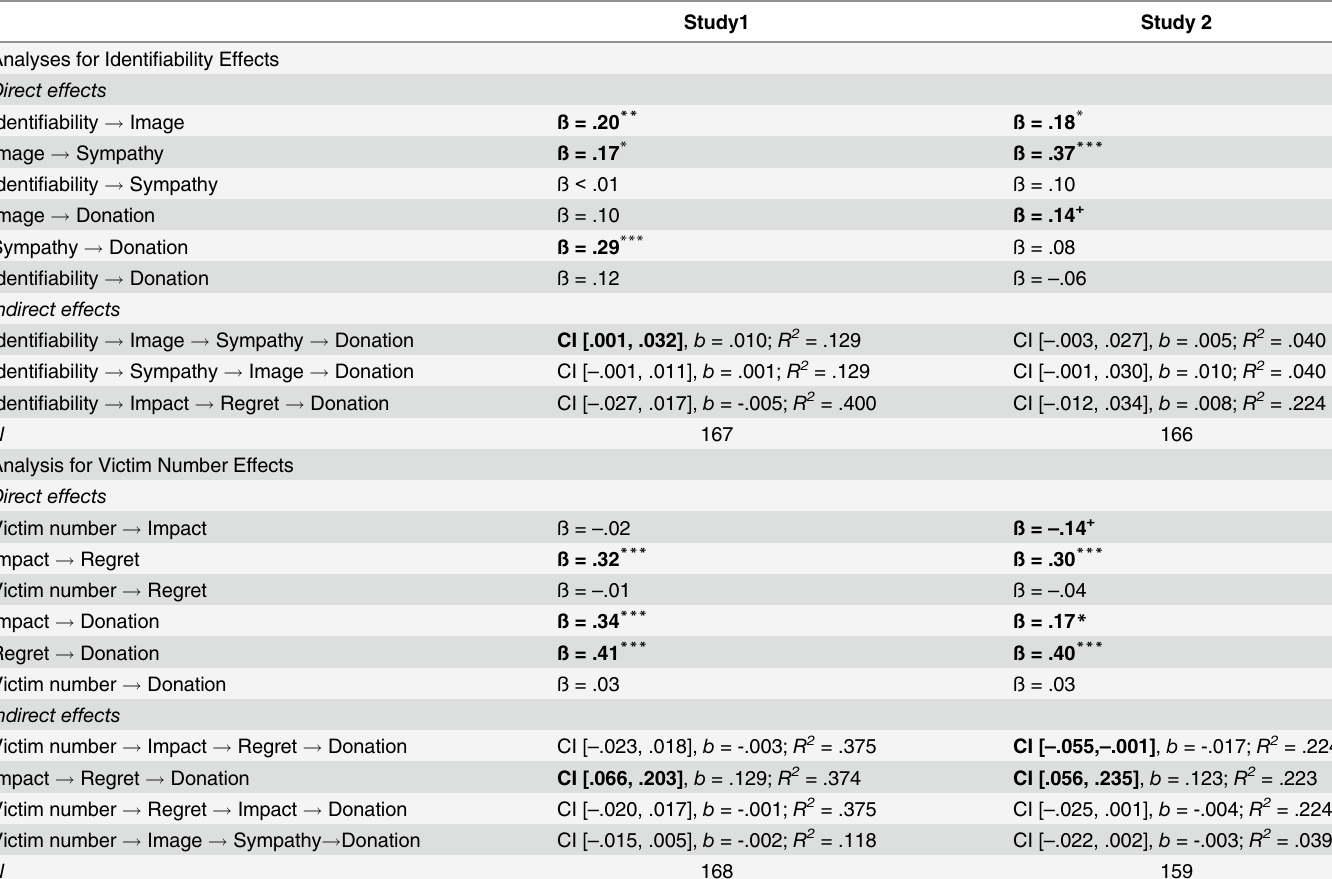
Table 2. Summary of the Main Mediation Results with Bootstrapping for Study 1 and Study